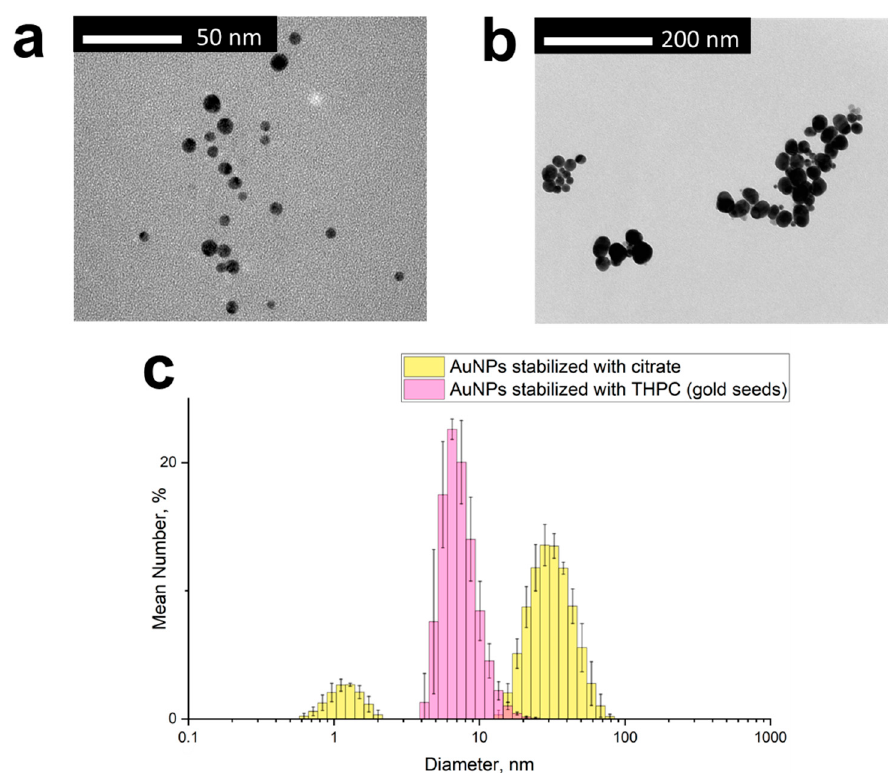
Figure 1. Characterization of AuNPs: ( a ) transmission electron microscopy (TEM) image of THPC gold seeds; ( b ) TEM image of AuNPs stabilized by citrate (yellow color); ( c ) size distribution histogram of gold seeds stabilized by THPC and AuNPs stabilized with citrate (pink color), revealed by dynamic light scattering (DLS).